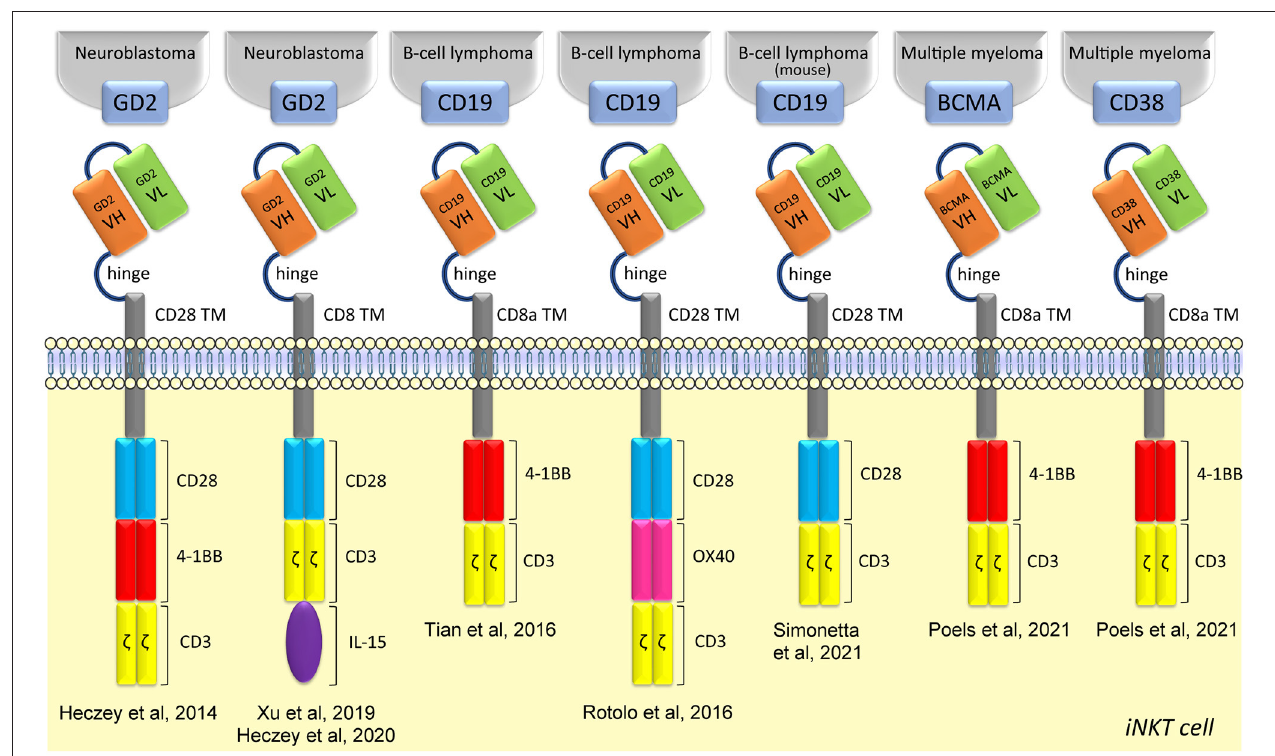
FIGURE 1 | Structure of CAR iNKT-cells. CAR iNKT-cells are composed of several parts: an extracellular single-chain variable fragment (scFv), a hinge for flexibility and distance, a transmembrane spacer, different intracellular costimulatory molecules, and TCR CD3 ζ